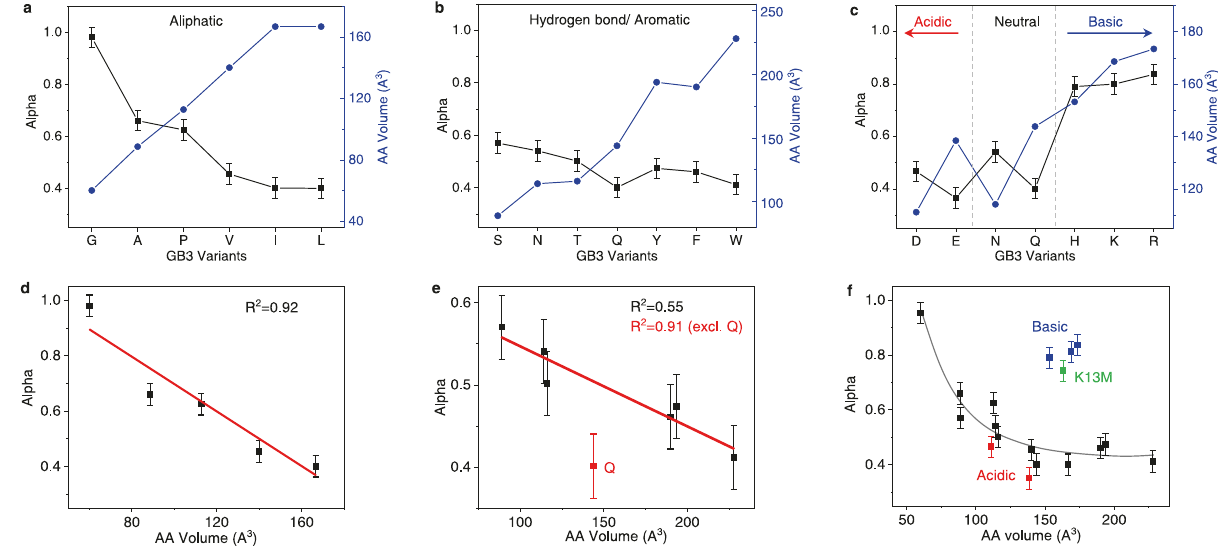
Fig. 2 | Effect of residue identity on binding af fi nity. Correlation of α value (black) and amino acid (AA) molecular volumes 69 (blue) for K13X variants with aliphatic side chains ( a ), hydrogen-binding/aromatic side chains ( b ), and electro- staticsidechains ( c ).The red arrowand blue arrowindicate increasing acidity and basicity. d , e Linear fi tting(red line)ofalphavaluesasafunction of AAvolumesfor variants presented in a and b . f , Relationship of alpha valuesand AA volume for all